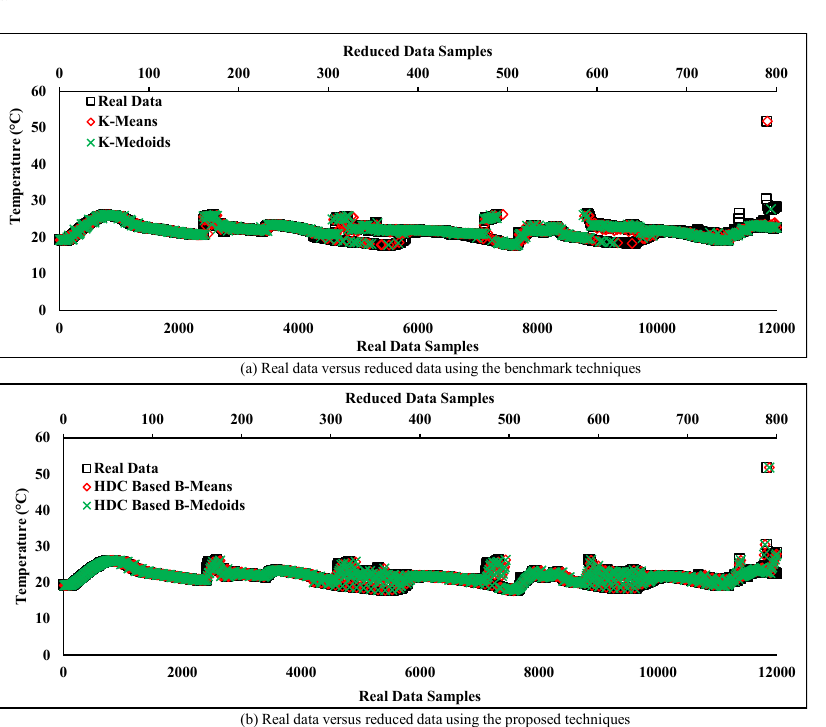
Figure 12. Performance comparison of normal real data with reduced data using the proposed and conventional techniques versus time. ( a ) Temperature versus normal real and reduced data based on conventional techniques; ( b ) temperature versus real and reduced data based on the proposed